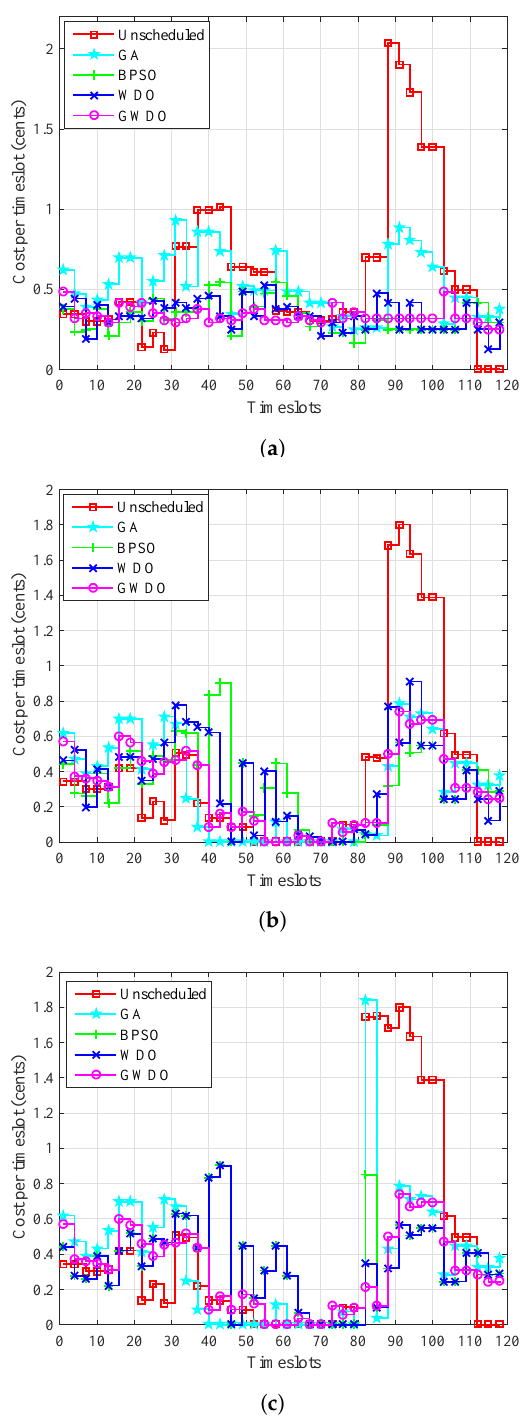
Figure 14. Electricity cost profile: ( a ) Without RESs and ESS; ( b ) With RESs; ( c ) With RESs and